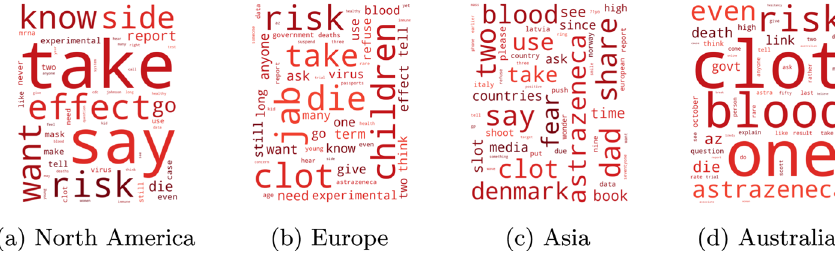
Fig. 9 Popular words in vax-skeptic tweets in different